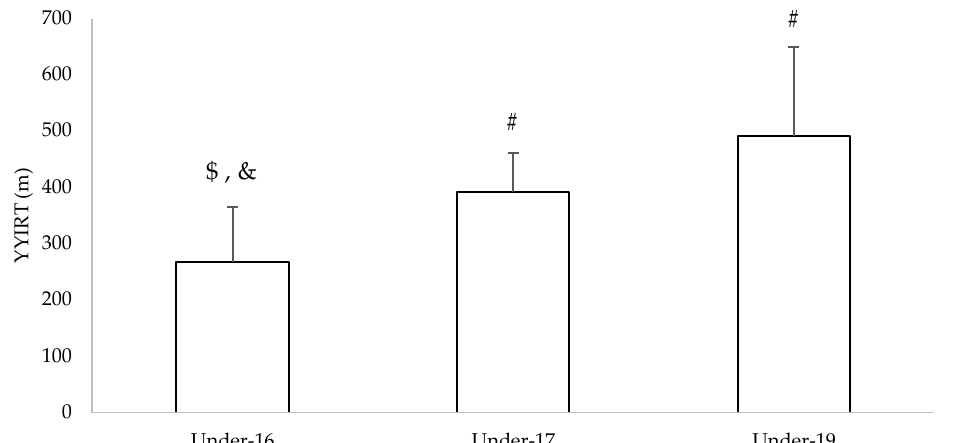
Figure 3. Descriptive statistics (mean and standard deviation) of the Yo-Yo Intermittent Recovery Test. #: significantly different ( p > 0.05) from under-16; $: significantly different ( p > 0.05) from under-17; &: significantly different ( p > 0.05) from under-19.